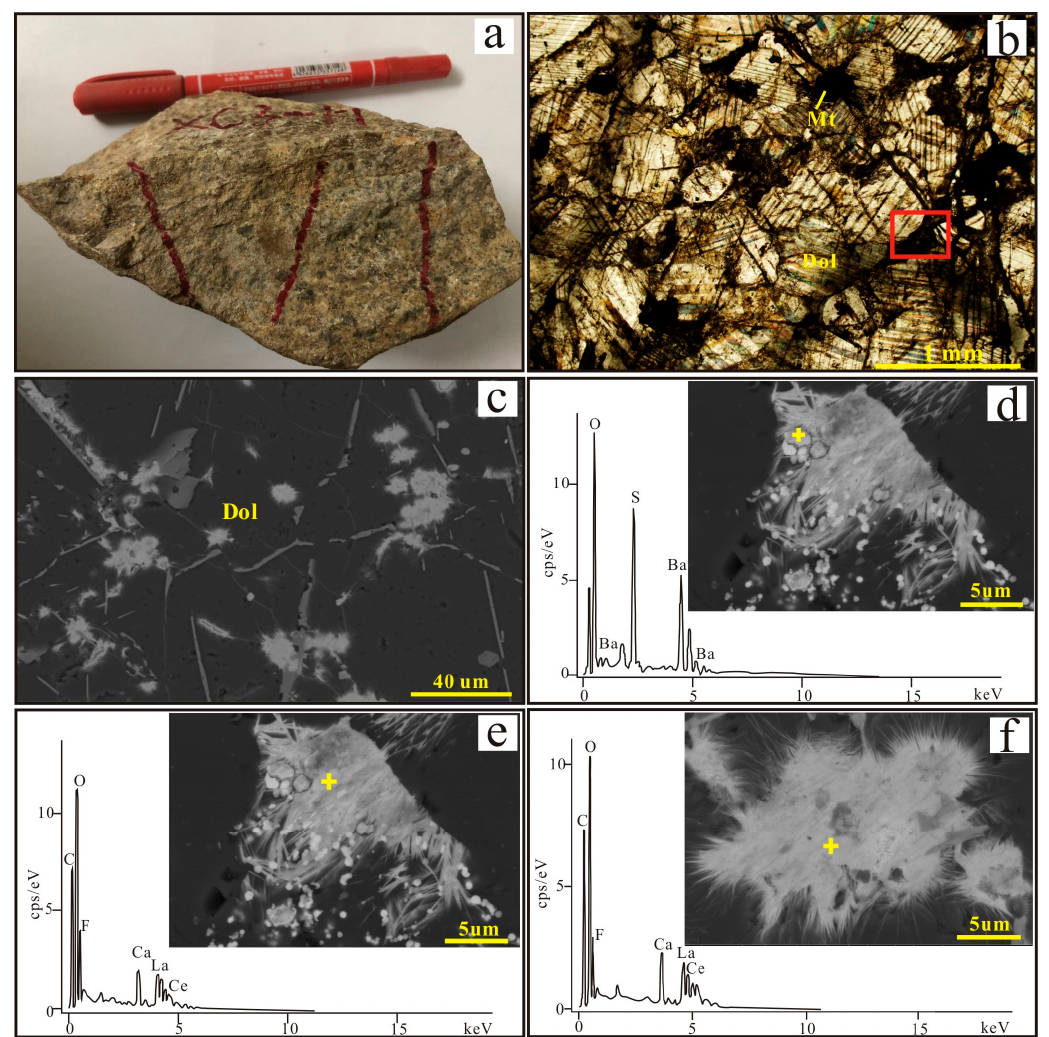
Figure 3. ( a ) Dolomite rock samples from the Dol-dyke. ( b ) Rock samples under microscope (cross-polarized light) showing constituent minerals of the rock and lots of hydrothermal minerals along the mineral boundaries. ( c ) Back-scattered-electron (BSE) image of the box area in Figure 3b. ( d – f ) are BSE images of detailed hydrothermal minerals with (EDS) of the marked area in each image, where baryte ( e ) and parisite ( e , f ) can be identified Abbreviations: Dol-dolomite, Ap-apatite.